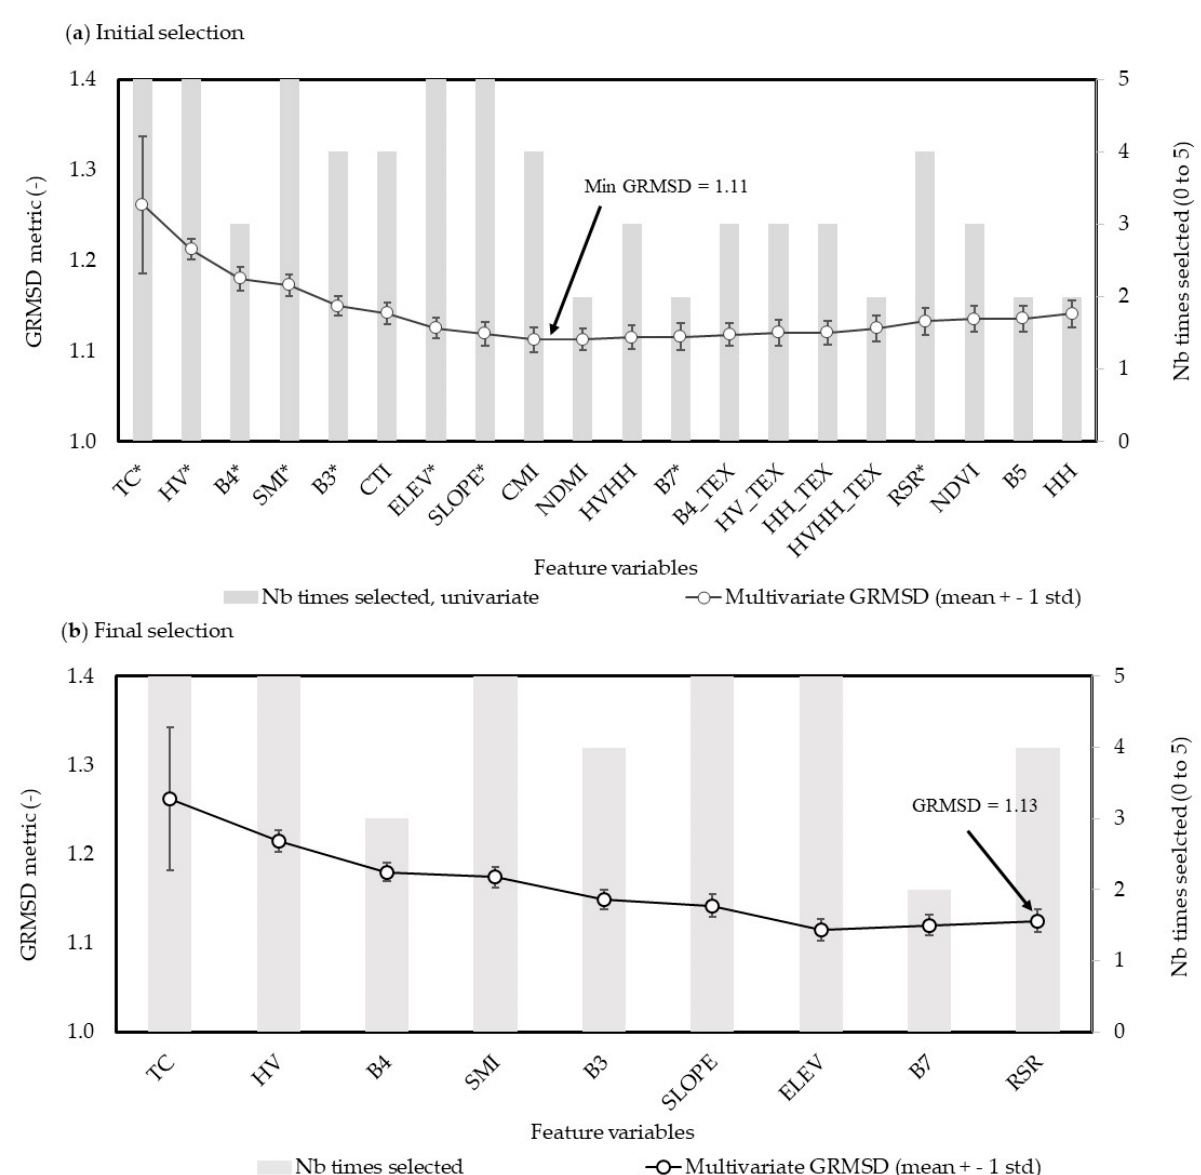
Figure 4. Multivariate global root mean square difference (GRMSD) metric (left Y axis) and the number of times a particular feature was selected in univariate feature selection across five attributes (right Y axis) for ( a ) initial selection features among the 20 candidate features and ( b ) the adjusted final selection of nine features (marked as * in panel ( a )).